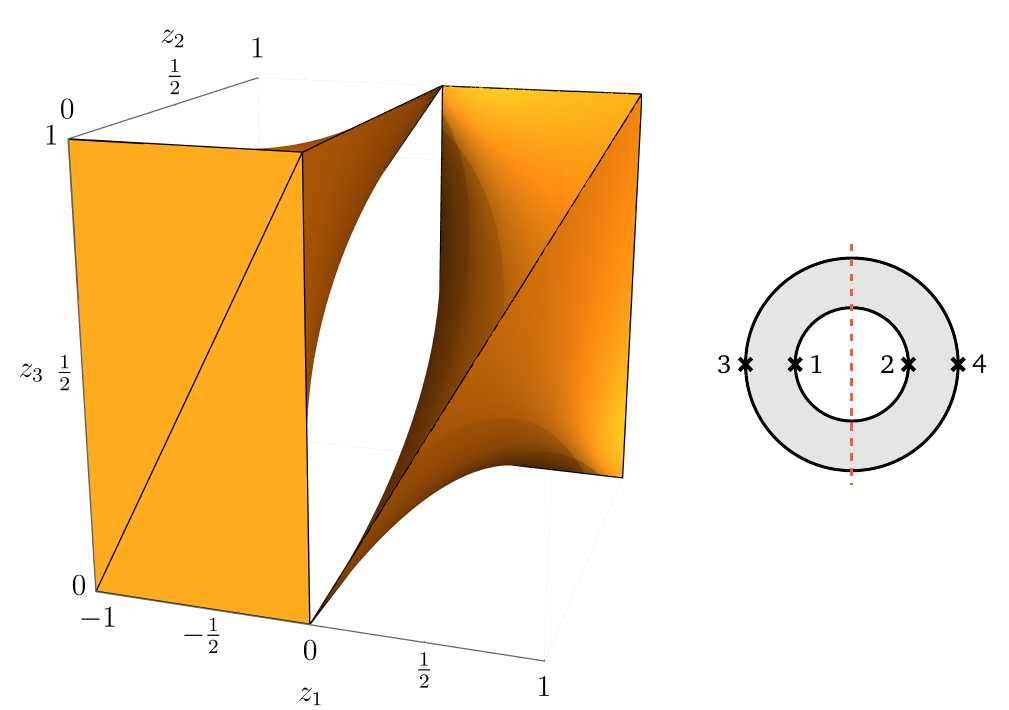
Figure 20: Left: the two regions with Trop < 0 for the u -channel of the non-planar annulus amplitude. Right: the unique unitarity cut in the u -channel of the non-planar annulus. It corresponds to the union of the two regions that fit together after a suitable